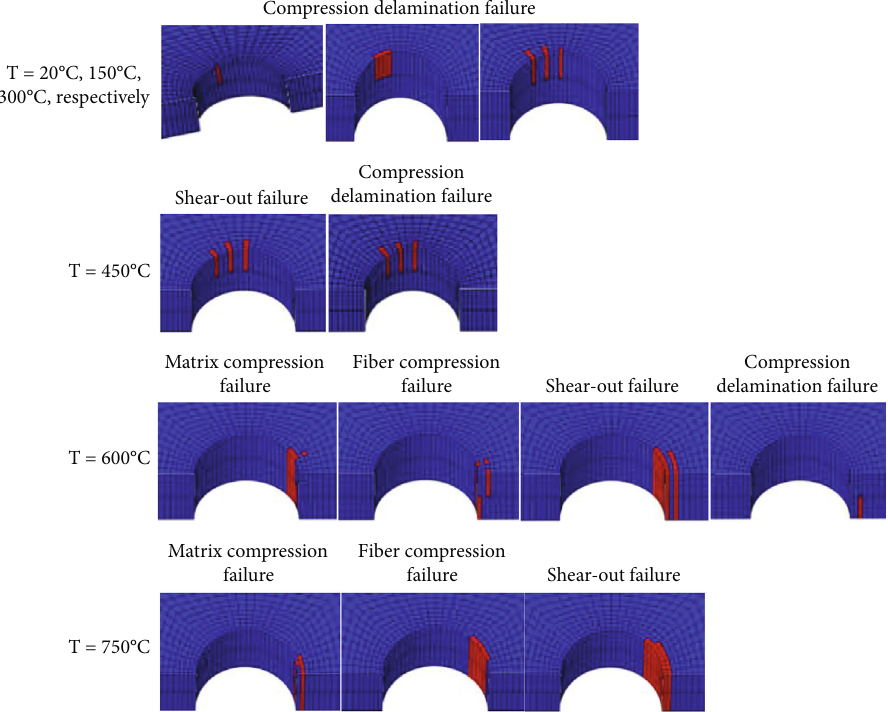
Figure 7: Damage failure patterns around the inner fastener hole of ceramic matrix plate of the double bolted joints at various temperatures.